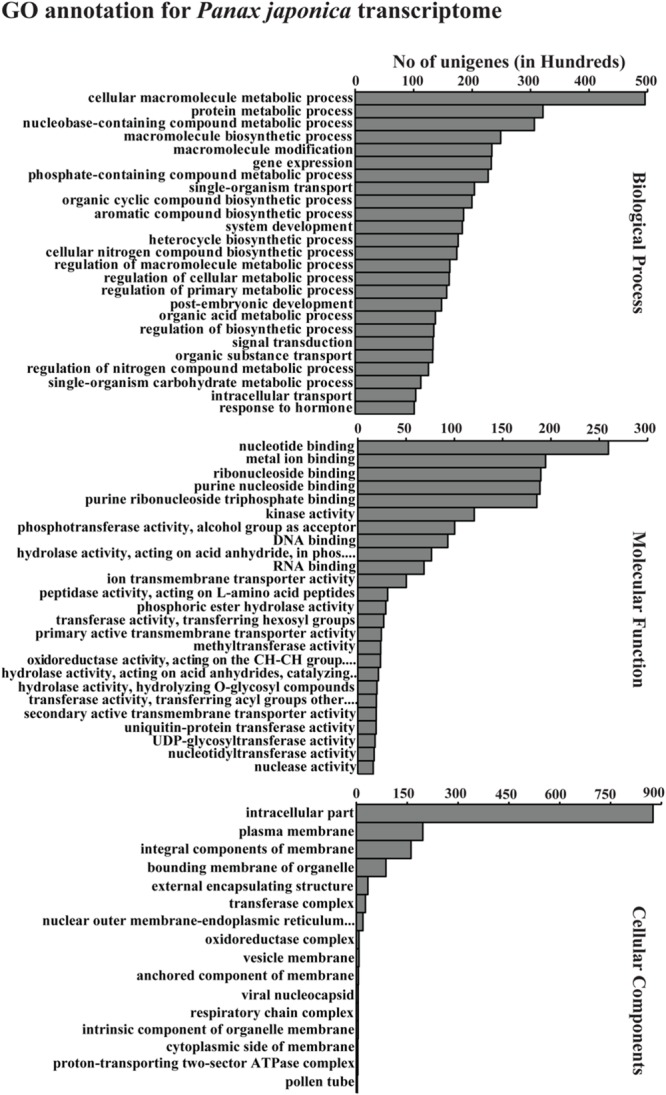
Gene ontology (GO) annotation for all assembled unigenes in P. japonicus. GO-terms for all unigenes were assigned based on Blast search results using Blast2GO program at GO annotation level 5. The results are summarized in terms of three functional categories, namely, biological process, molecular function, and cellular component.